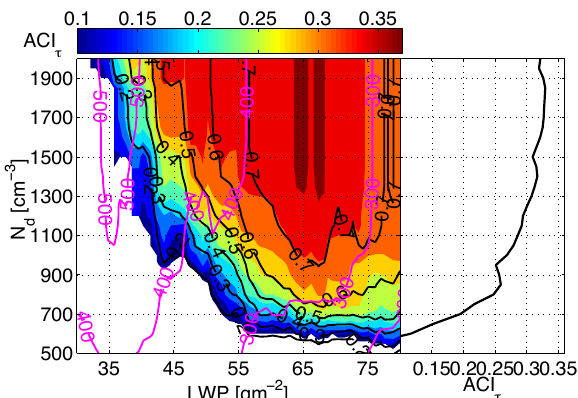
Figure 10: ACI τ as a function of LWP and for different upper N d thresholds (left panel). Black and magenta contours indicate the linear correlation and number of samples per bin respectively. ACI τ and correlations are statistically significant at the 99.9% confidence level according to a one-tailed Student’s t test. The right panel corresponds to the average ACI τ per N d threshold.